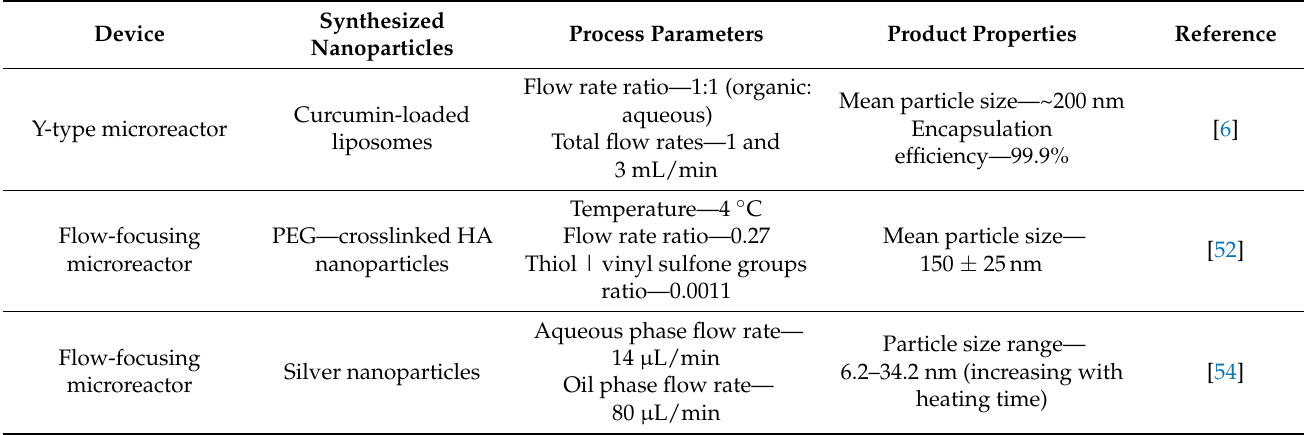
Table 1. Overview of discussed microfluidic devices for nanoparticles